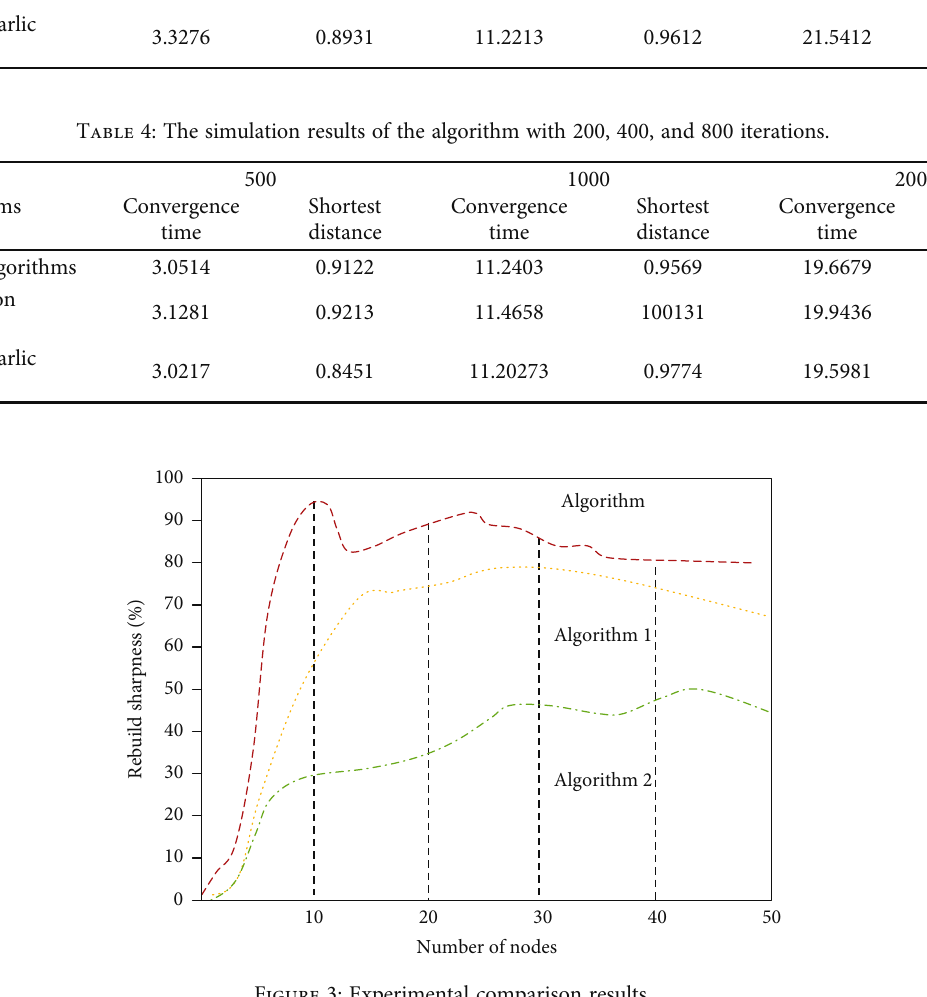
Figure 3: Experimental comparison results.